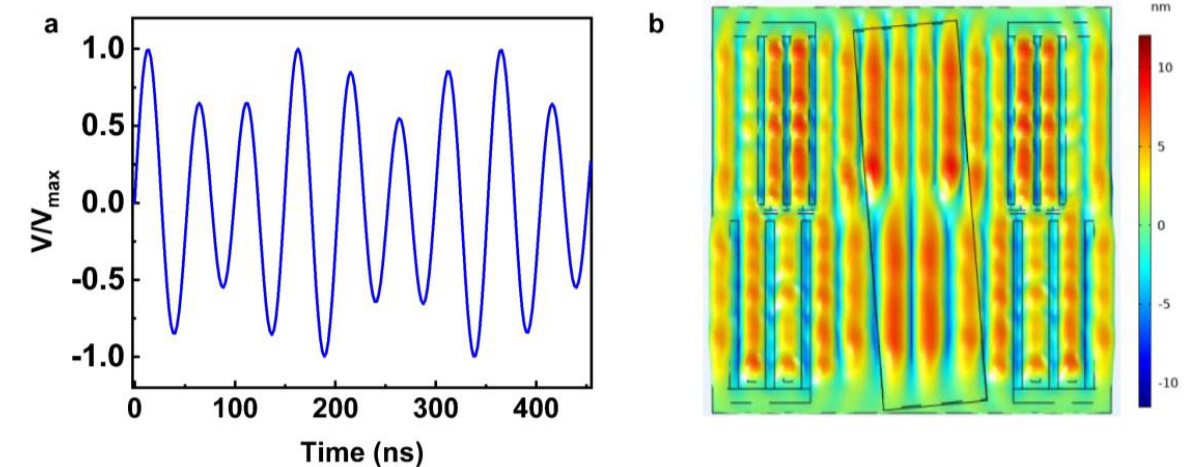
Figure 9. The modulated driving signal composed of two different frequencies with different am- plitudes ( a ); the surface displacement generated by the multi-stage IDT driven by modulated signal ( b